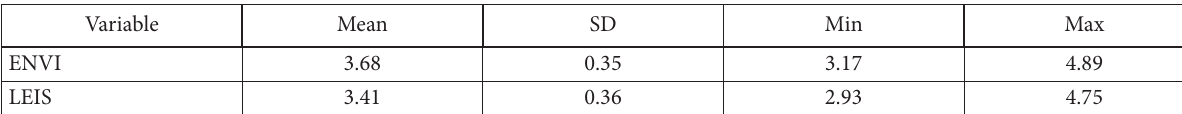
Table 3. Descriptive statistics of second-level variables (N = 24) Variable